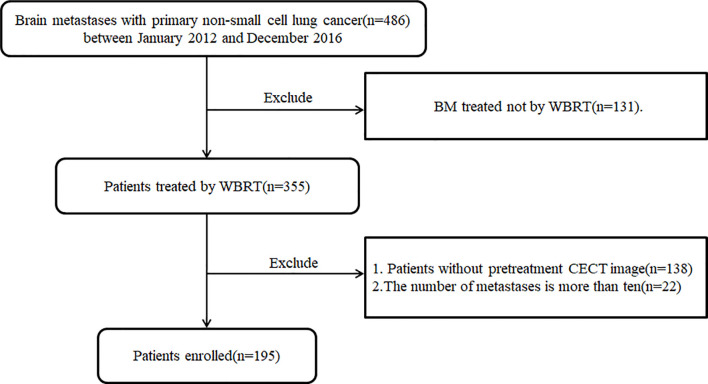
The flowchart of patients’ selection for this retrospective study.